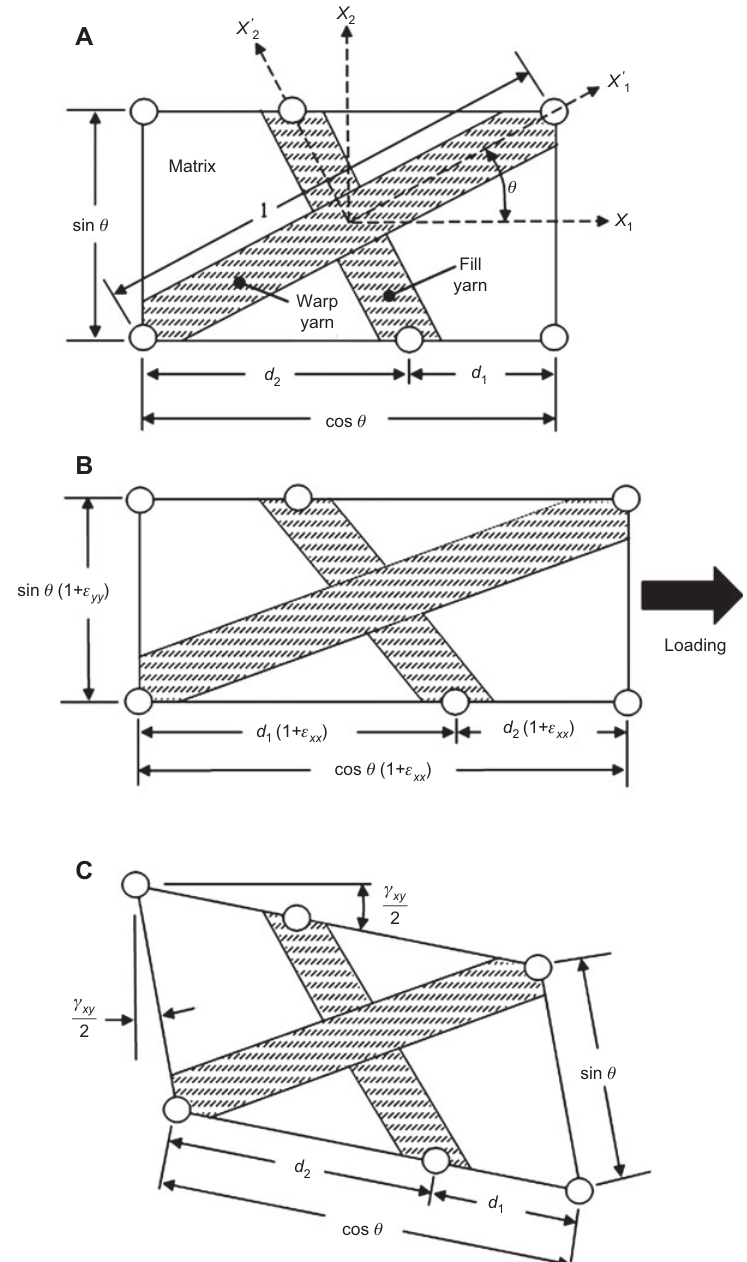
Figure 6 Parametric RVE: (A) original confi guration, (B) extension, and (C) shear deformation.